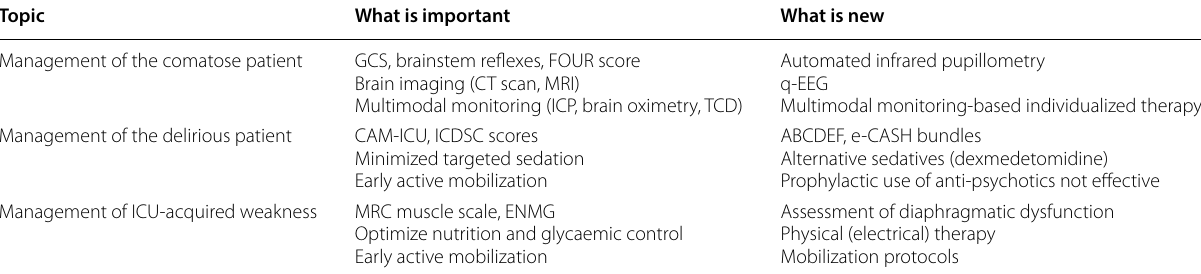
Table 1 Care of the injured brain in the general ICU: basic comprehensive aspects Topic What is important Management of the comatose